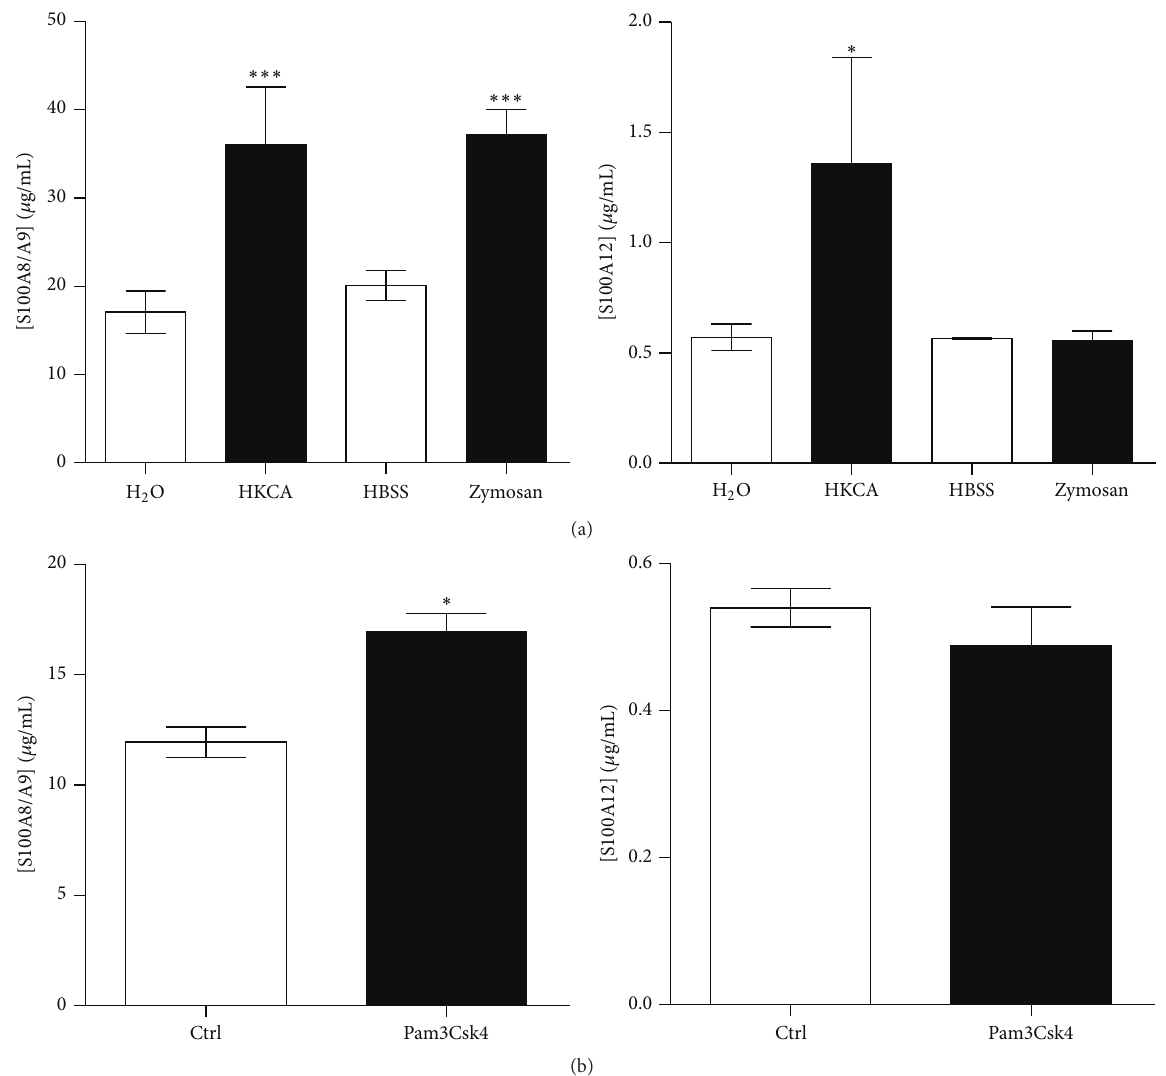
Figure 3: Effects of microbe-derived products and whole yeasts on the release of S100A8/A9 and S100A12. (a) C. albicans (10 8 cells/mL) enhances the secretion of S100A8/A9 and S100A12, whereas zymosan (1.5mg/mL) induces only the release of S100A8/A9. (b) Pam3CSK4 (TLR2 ligand, 10 𝜇 g/mL) potentiates the release of S100A8/A9 but not S100A12. Neutrophils were incubated with whole microorganisms or microbe-derived product for 60 min at 37 ∘ C. The concentrations of secreted S100A8/A9 and S100A12 were determined by ELISA. Results are the mean ± SEM of at least three independent experiments performed on neutrophils from different donors. ∗ 𝑃 < 0.05 and ∗∗ 𝑃 < 0.01 compared with control by paired 𝑡